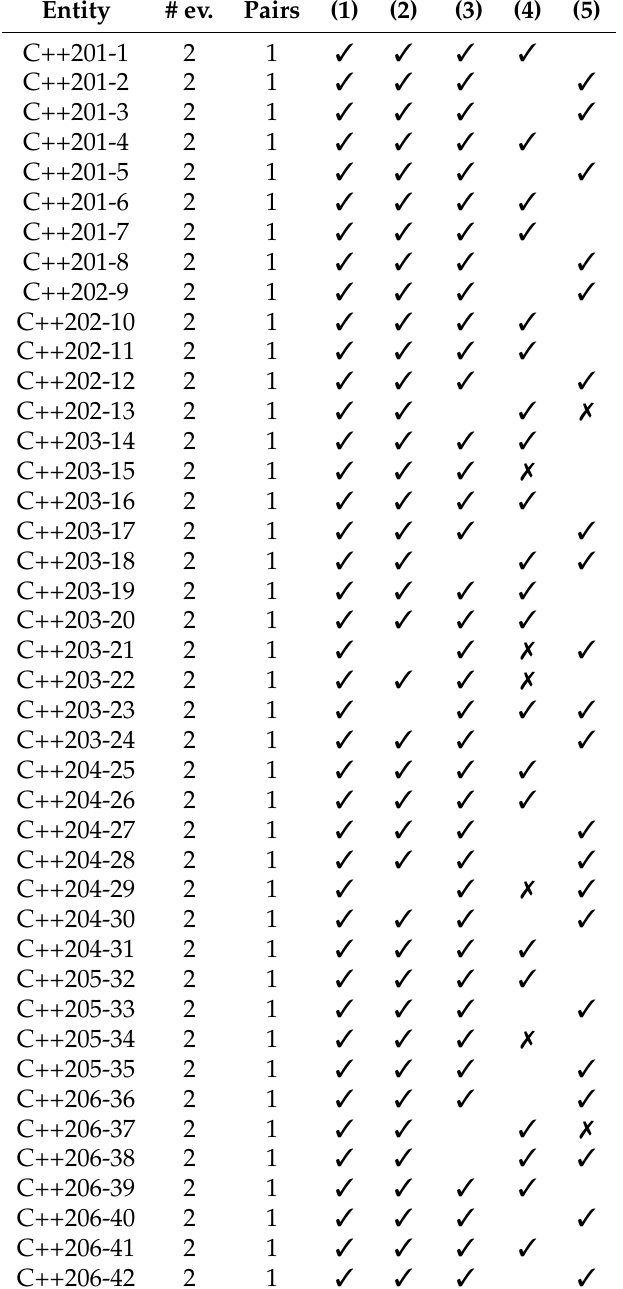
Table 11. Results of expert judgment for classes in C++ programming language, with assessed quality aspects, overall quality (1); source code size (2); class complexity (3); class cohesion (4) and class coupling (5); based on an evaluation using a combination of software